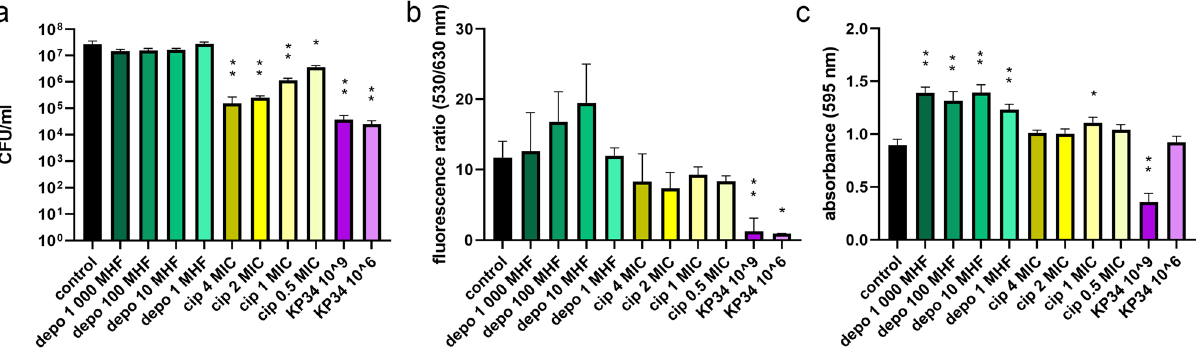
Figure 2. The influence of depolymerase, ciprofloxacin, and infective phage KP34 on K. pneumoniae 77 biofilm formed for 48 h on polystyrene pegs. Two-day biofilm was treated for 2 h with: recombinant depolymerase KP34p57 originated from phage KP34 marked as depo, at concentrations corresponding to 1000 MHF (minimal halo forming concentration), 100 MHF, 10 MHF, and 1 MHF, green bars; ciprofloxacin marked as cip, at concentrations corresponding to 4 MIC (minimal inhibitory concentration), 2 MIC, 1 MIC, and 0.5 MIC, yellow bars; and lytic phage KP34 marked as KP34 (10 9 PFU/ml and 10 6 PFU/ml, violet bars). Biofilm eradication was examined with three different microtiter methods: ( a ) the colony count (CFU/ml); ( b ) LIVE/DEAD BacLight Bacterial Viability Kit with live to dead cells ratio at fluorescence 530/630 nm; ( c ) the crystal violet staining and the level of absorbance at 595 nm. P -value < 0.001 (indicated as two asterisks) and P- value between 0.01 and 0.001 (indicated as one asterisk) were considered statistically significant.